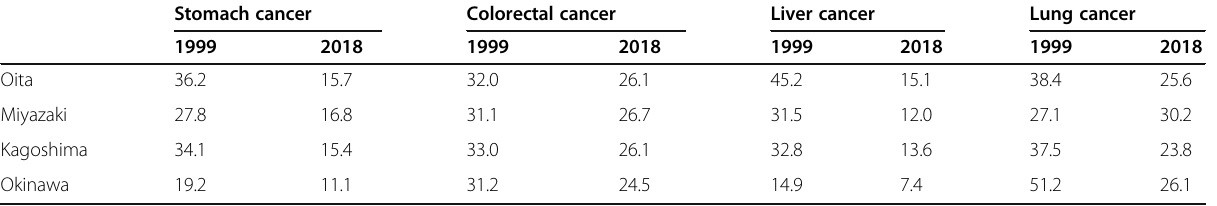
Table 2 Age-standardized mortality rates for each type of cancer in 1999 and 2018 among women (Continued)